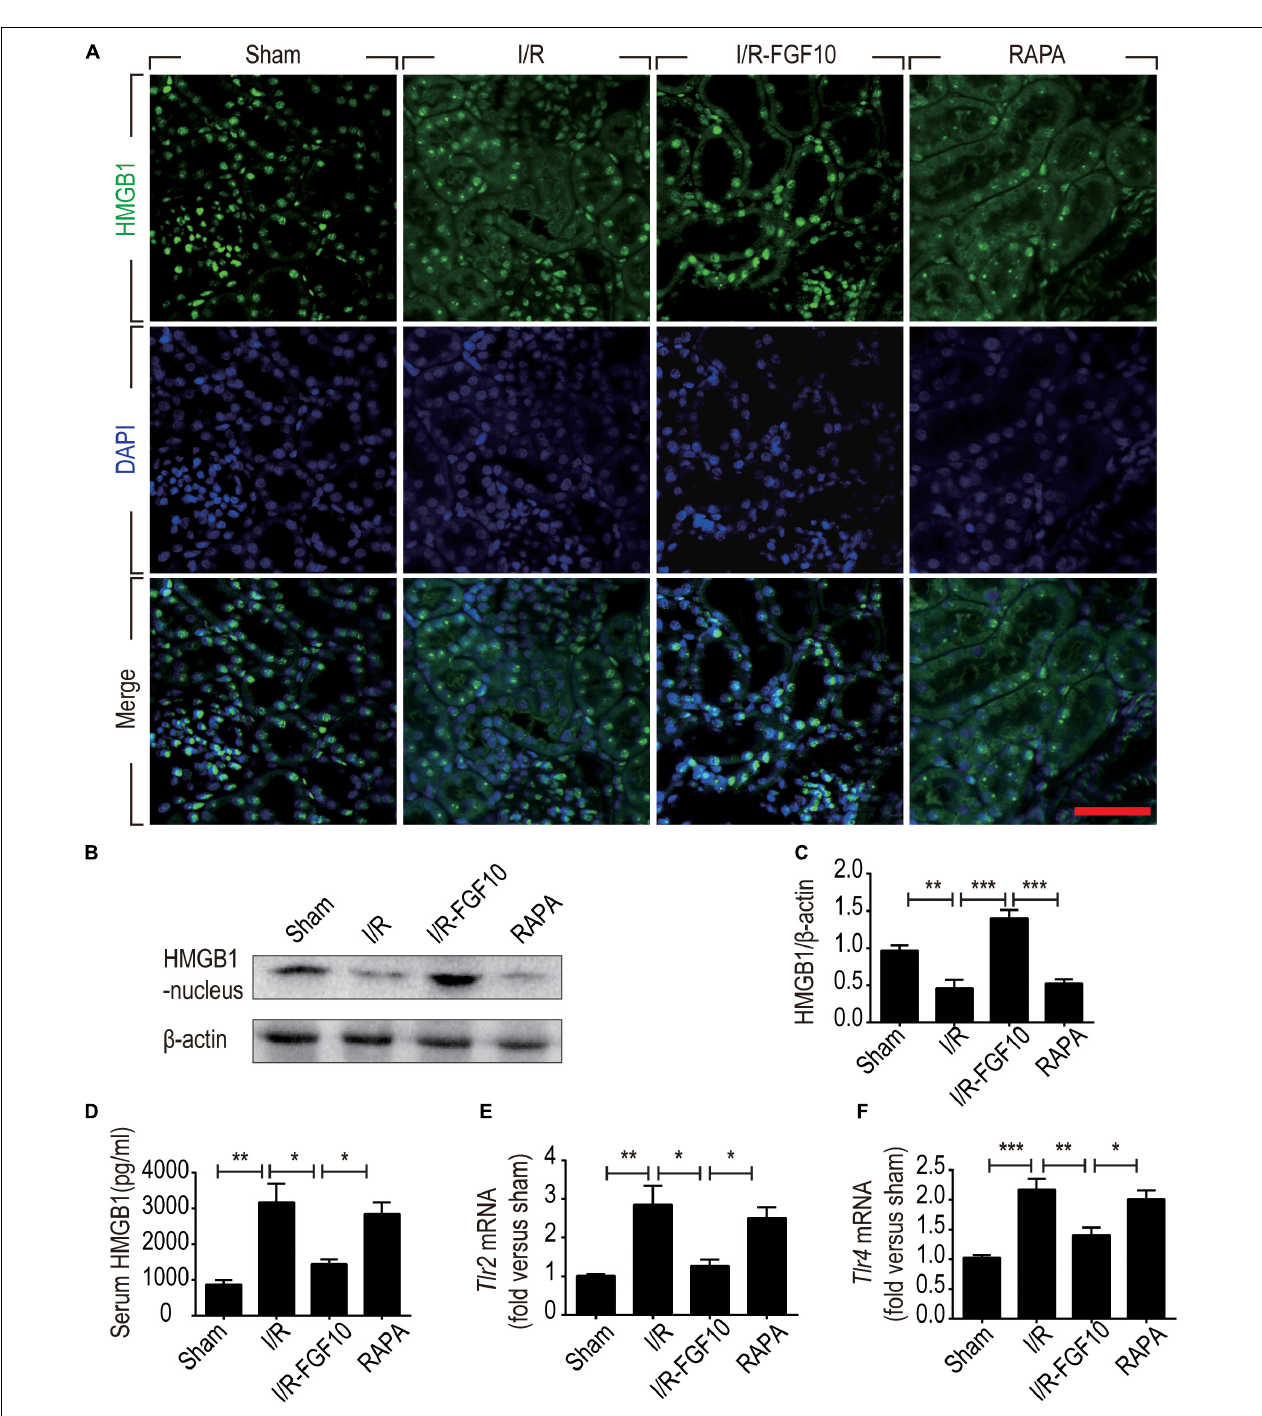
FIGURE 7 | FGF10 inhibits the release of nuclear HMGB1 to the serum and regulates the TLR mRNA expression. (A) Immunofluorescence staining of HMGB1 at 2 days after reperfusion. Nuclei were labeled with DAPI (blue). Scale bars = 50 µ m. (B,C) Protein expression of HMGB1 in the nuclear fraction of renal tissues by Western blot and optical density analysis with β -actin as loading control (mean ± SEM; n = 5). ∗∗ P < 0.01, ∗∗∗ P < 0.001. (D) Level of serum HMGB1 was determined by ELISA (mean ± SEM; n = 5). ∗ P < 0.05, ∗∗ P < 0.01. (E,F) Expression of Tlr2 and Tlr4 mRNA in the kidney were examined by RT-qPCR and normalized to Gapdh. ∗ P < 0.05, ∗∗ P < 0.01, ∗∗∗ P <